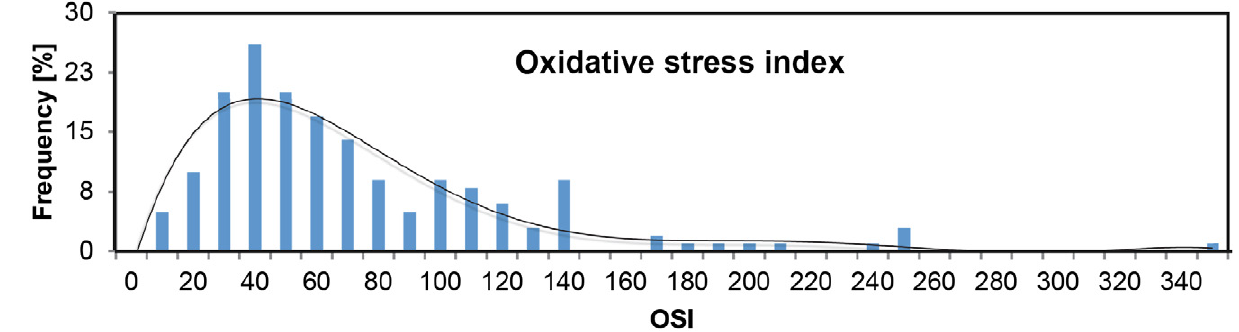
Figure 2: Calculated OSI of the whole study group. * OSI - index of oxidative stress